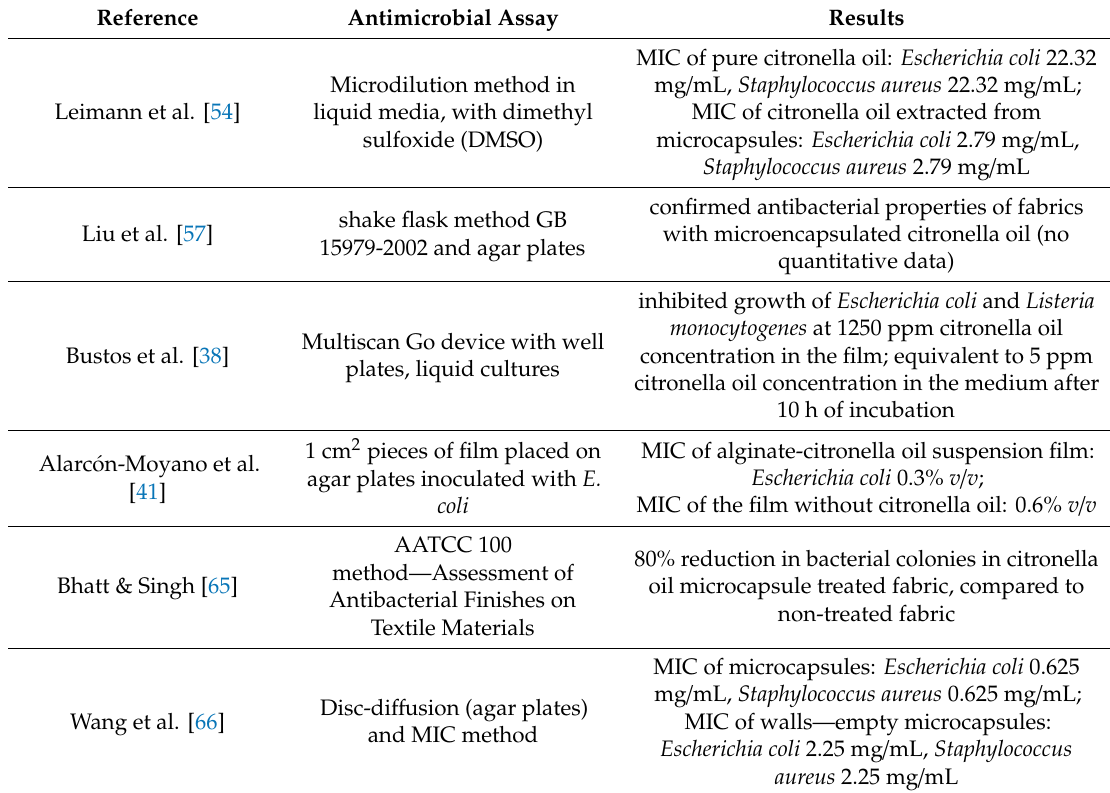
Table 3. Reported antimicrobial activities and minimum inhibitory concentration (MIC) values of microencapsulated citronella oil or corresponding